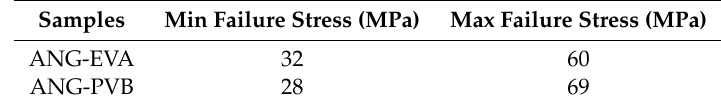
Figure 13. Experimental setup and crack patterns; courtesy of Tomáš Hána from CTU in Prague. Table 8. Extreme tensile failure stresses on the bottom surface of laminated glass under four-point